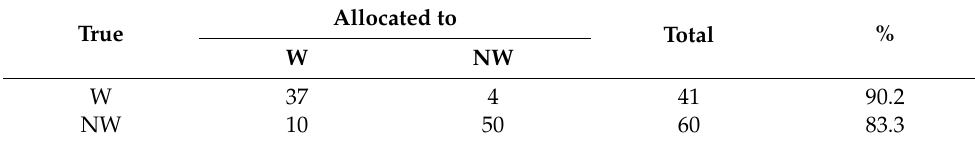
Figure 3. Discriminant analysis histogram. Grouping variable: Walking (W)/not-walking (NW). Table 3. Discriminant analysis classification/misclassification scores.